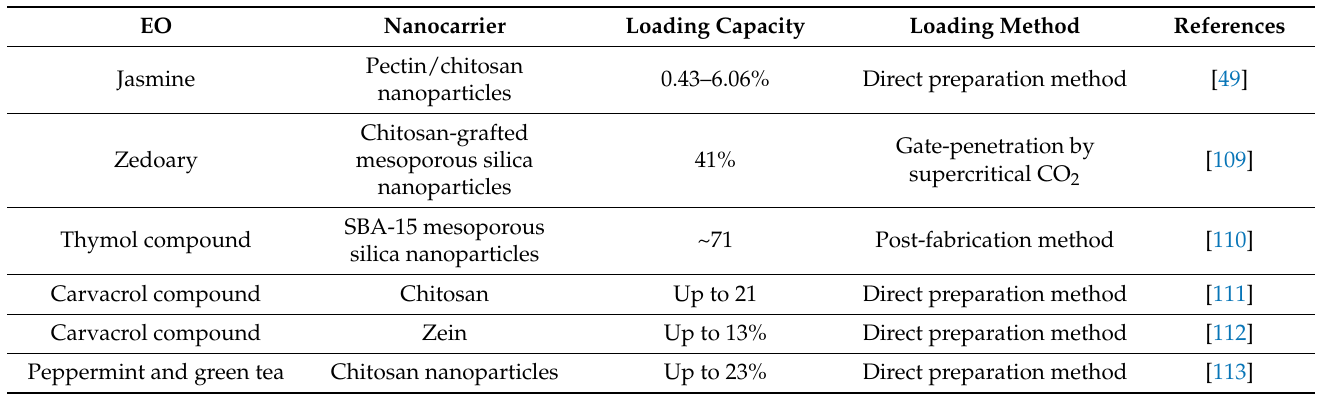
Table 1. Loading capacity and method for various EOs with different nanocarriers.